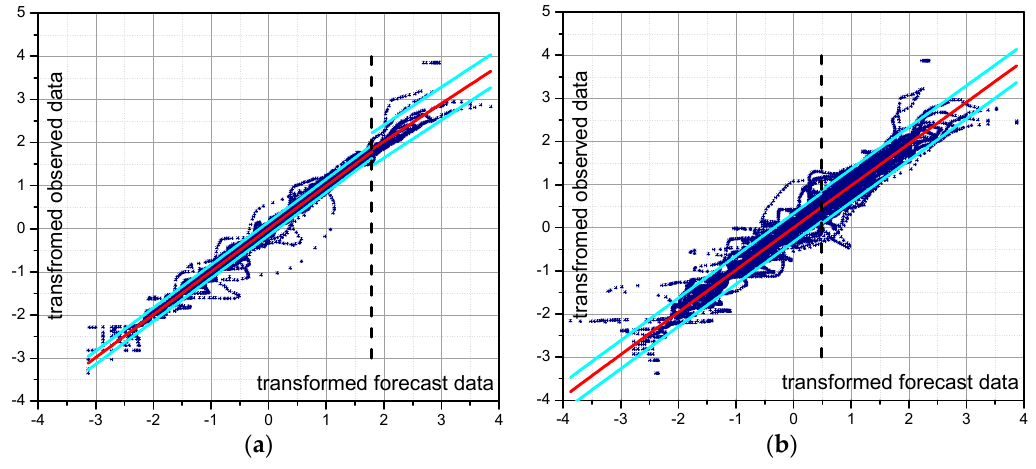
Figure 5. Division of the joint distribution in the transferred normal space (i.e., space fulfilling assumptions of normality) into two bivariate truncated normal distributions for: ( a ) Bhadrachalam ‐ Polavaram reach (lead ‐ time = 12 h); and ( b ) Perur ‐ Polavaram reach (lead ‐ time = 24 h). The red line represents the mean value, while the light blue lines represent the 5% and the 95% quantiles. The black dashed line represents the threshold used in order to identify the two TNDs.